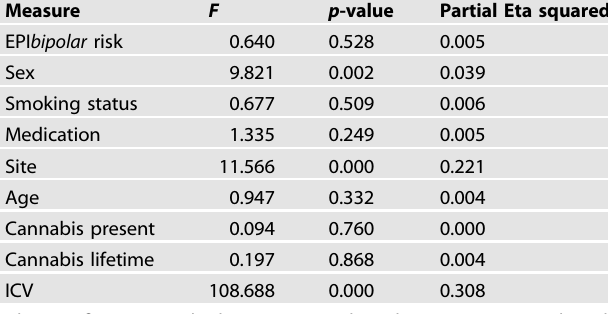
Table 3. Results of the generalized linear models using the hippocampal volume as an independent variable.